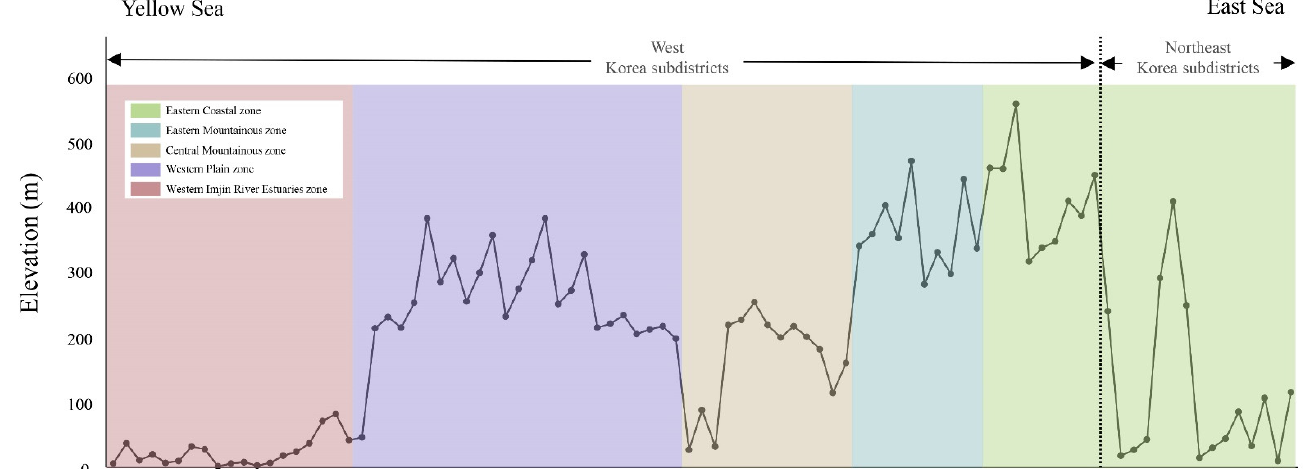
Figure 2. Longitudinal profile of the adjacent area of the DMZ and its subdivision into five zones and two subdistricts based on the survey regions and biogeographic regions. The colors represent the five survey regions and two subdistricts, and the elevation of each survey site is indicated by a dot on the black line.